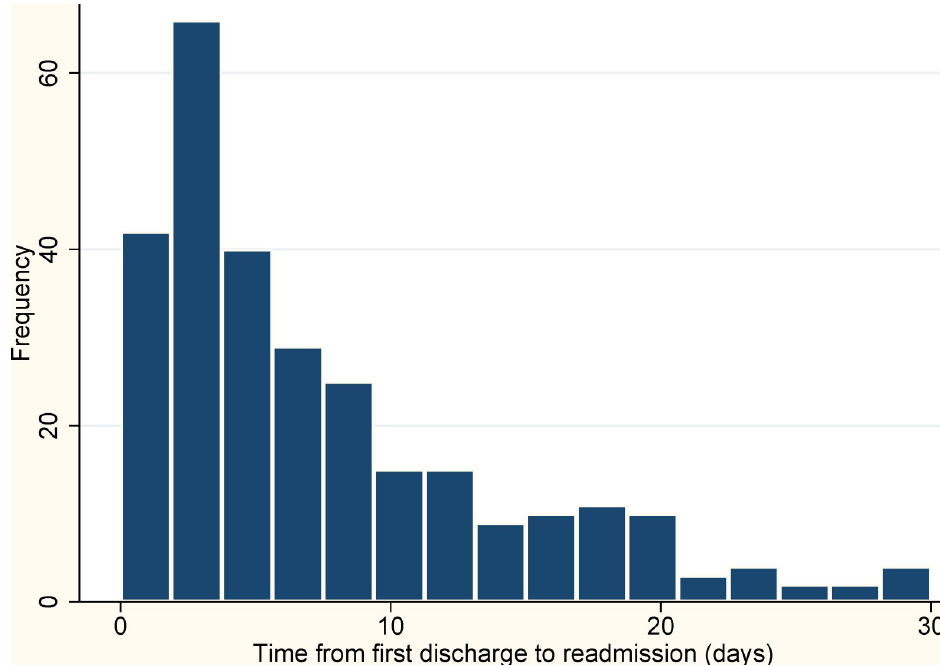
Fig 4. Time from first discharge to subsequent hospital encounter among 18–29 year-old COVID-19 patients discharged home from initial encounter.